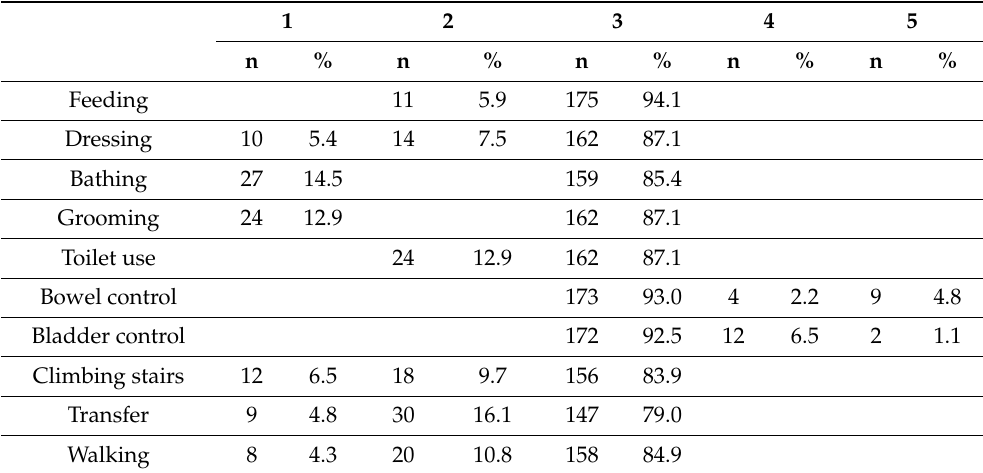
Table 2. Distribution of the sample responses as to the type of dependency by area of